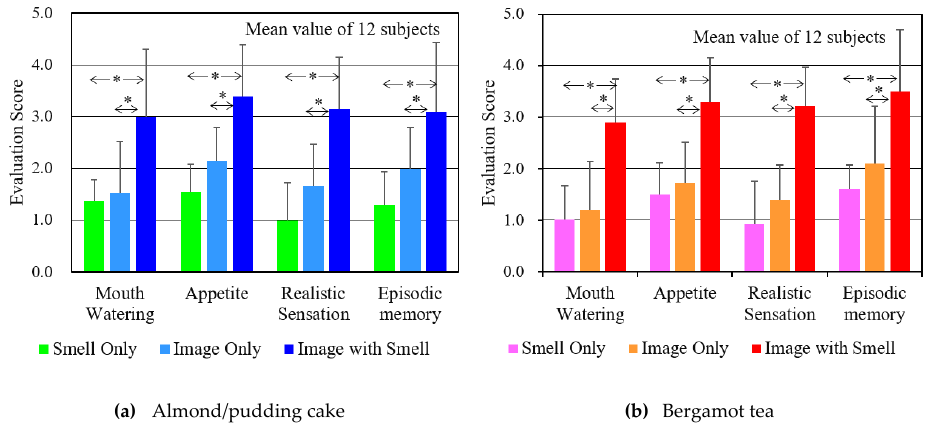
Figure 8. Subjective evaluation score upon feeling “mouth-watering”, “Appetite”, “Realistic Sensation”, and “Episodic Memory” for estimating the sense of presence when watching food images.